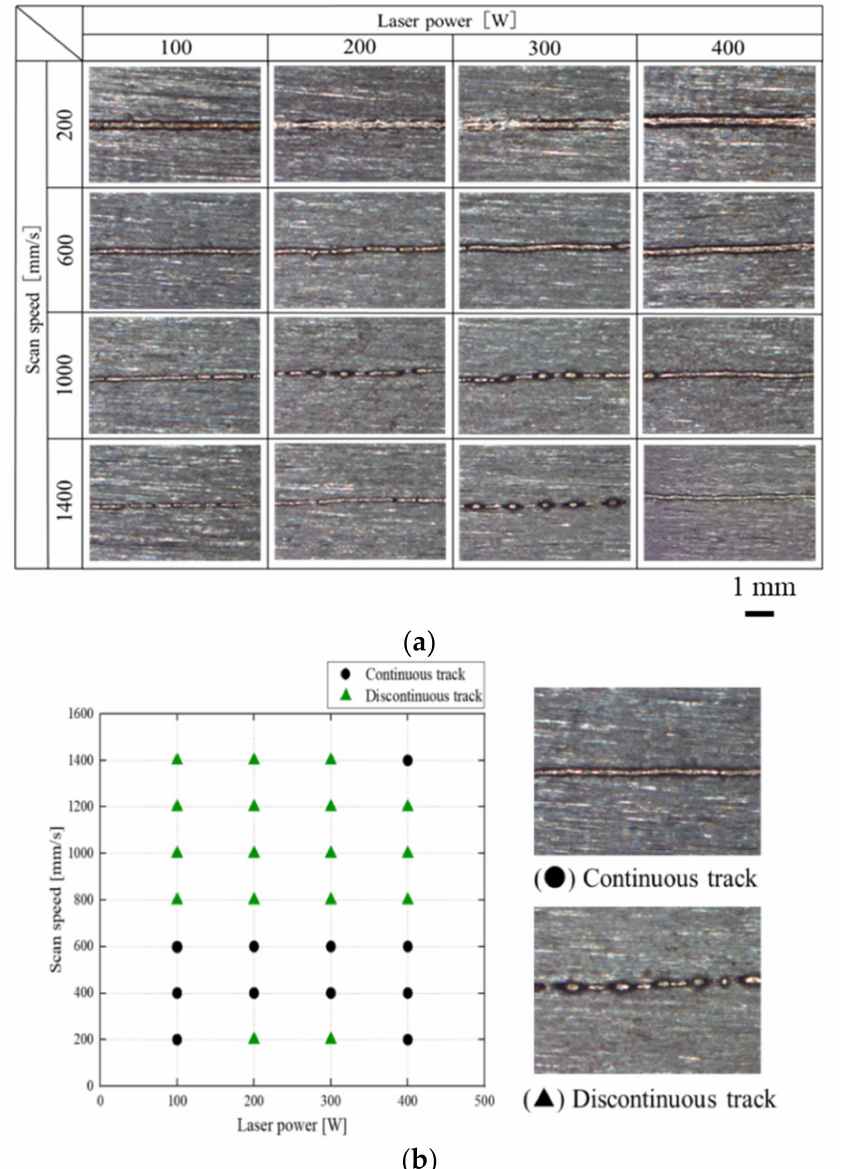
Figure 3. The SEM images of single tracks and the process map in terms of laser power and scan speed evaluated by the morphology of single tracks fabricated under condition I (Laser spot diameter: 0.1 mm). ( a ) SEM images of single tracks; ( b ) process map in terms of laser power and scan speed evaluated by the morphology of single